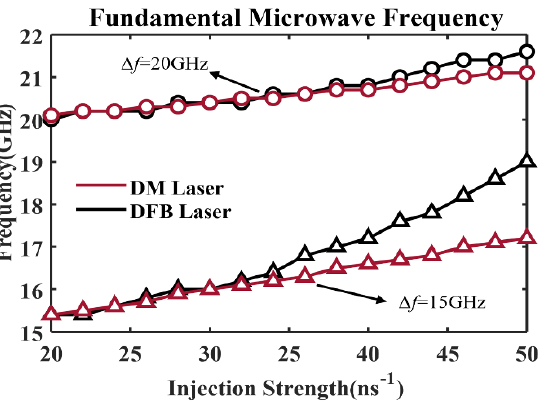
Figure 10. Numerical simulation of the generated microwave frequency as a function of the injection strength utilizing DM laser model and DFB laser model. ∆ f = 15 and 20 GHz.